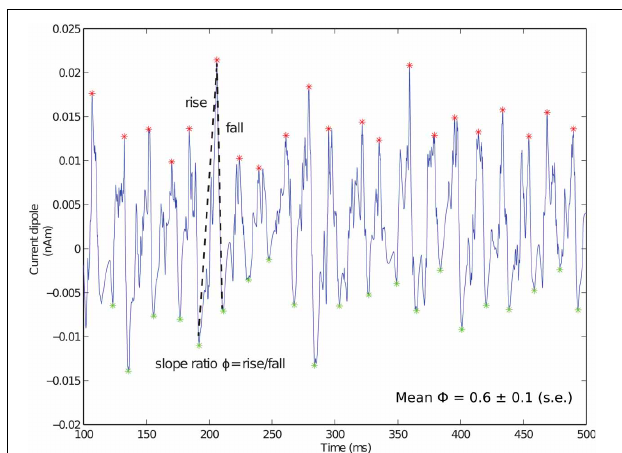
FIGURE 3 | Fast inhibition creates sharp falling phase of current dipole in weak PING. Example weak PING current dipole (nAm) simulation, with peaks (red) and troughs (green) marked. Slope ratio ( (cid:3) ) defined as mean of ratios of rising slope to falling slope (depicted by dotted lines) for each cycle of rhythm. (cid:3) for weak PING was 0.6 ± 0.1 (s.e.), reflecting sharp inhibition responsible for rapid fall. g pois = 0.75 × 10 − 2 mS/cm 2